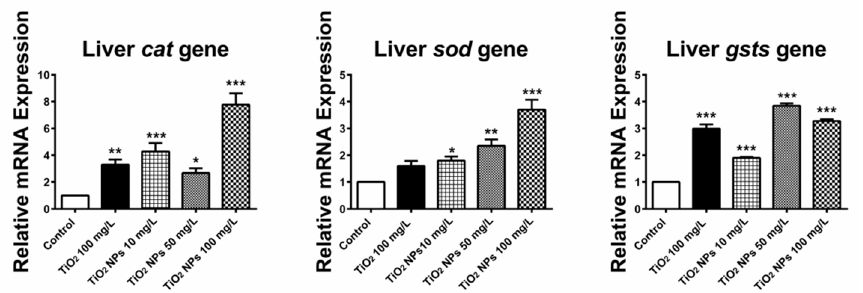
Figure 8. Change in the relative expression level of three antioxidant related genes (CAT, SOD and GSTS) in livertissue. *, ** and *** indicate statistically significant differences from control values at p < 0.05, p < 0.01 and p < 0.001, respectively.